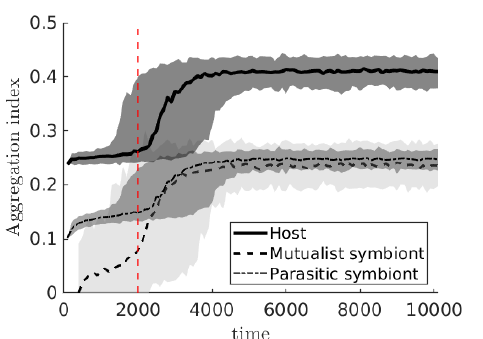
Figure SI.7. Aggregation index of the spatial distribution of hosts (plain curve), parasitic symbionts (dash- dotted curve) and mutualistic symbionts (dashed curve) over time. The shadow regions corresponds to the 95% confidence interval and curves corresponds to the median over 100 replicates. The parameters are similar as Figure